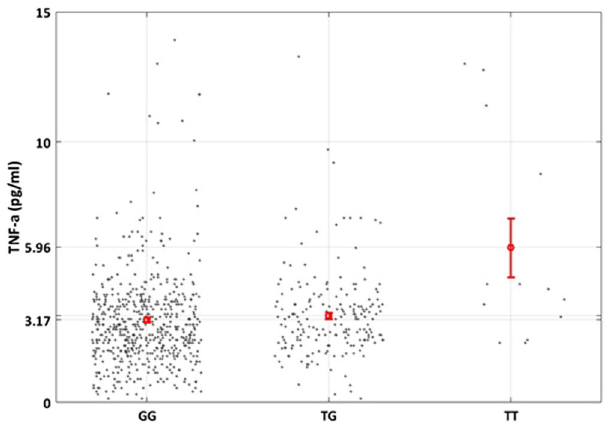
Figure 1. Mean values of TNF- α levels according to the different genotypes of rs6918289 (GG vs TG vs TT) in the SFS population. Thin bars show standard